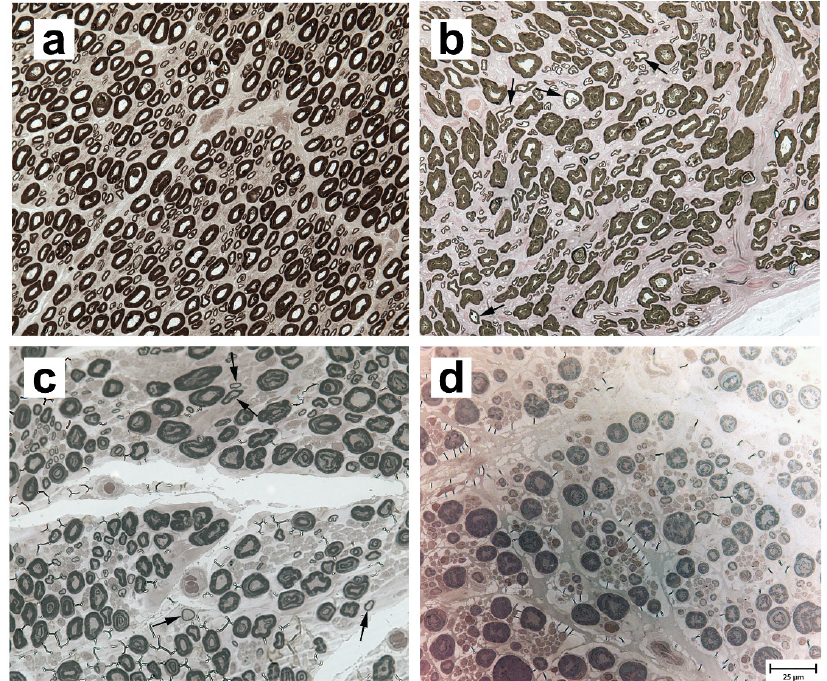
Figure 1. Paraphenylenediamine-stained resin sections from the peroneal nerves of four dogs. ( a ) An adult normal control Labrador retriever, ( b ) a nine-year-old LPPN-affected Labrador retriever, ( c ) a three-year-old LPPN-affected Leonberger, and ( d ) a three-year-old LPPN-affected Saint Bernard. All three LPPN-affected dogs were homozygous for the CNTNAP1 variant. Arrows in ( b ) and ( c ) point to nerve fibers that are inappropriately thin for the axon diameters. Bar in lower right image indicates 25 µm and is valid for all images.